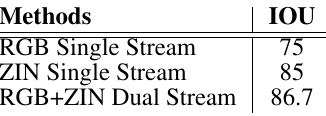
Table 1. Performance Comparison of Segmentation